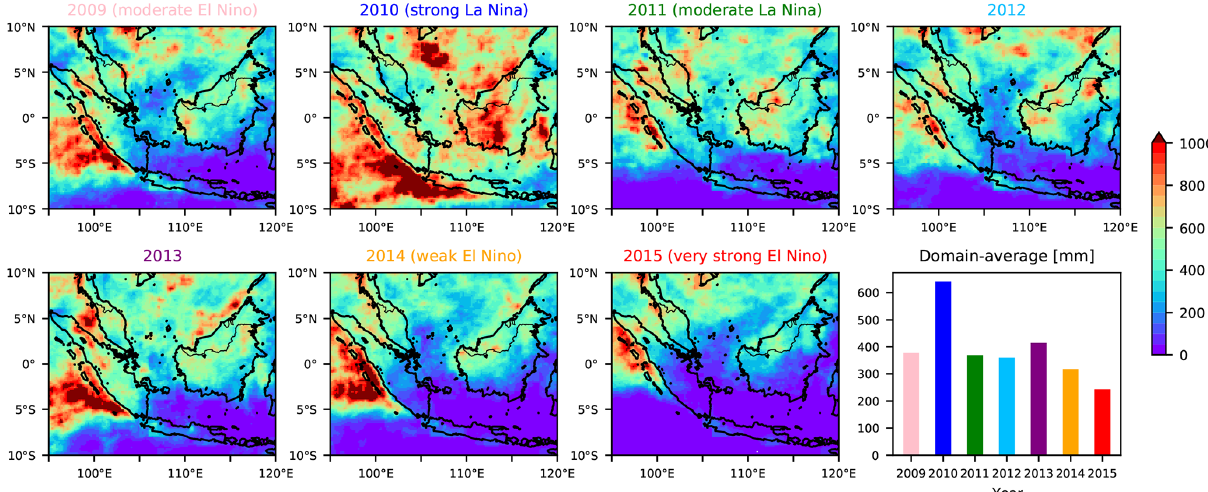
Figure 1. The 2-month accumulated precipitation (mm) observed by TRMM in September and October of each year from 2009 to 2015, calculated from the monthly mean precipitation rate data (TRMM 3B43). Domain-mean amounts are shown in the bar graph at lower right. The ENSO phases are based on the 3-month running mean Oceanic Niño Index (https://origin.cpc.ncep.noaa.gov/products/analysis_